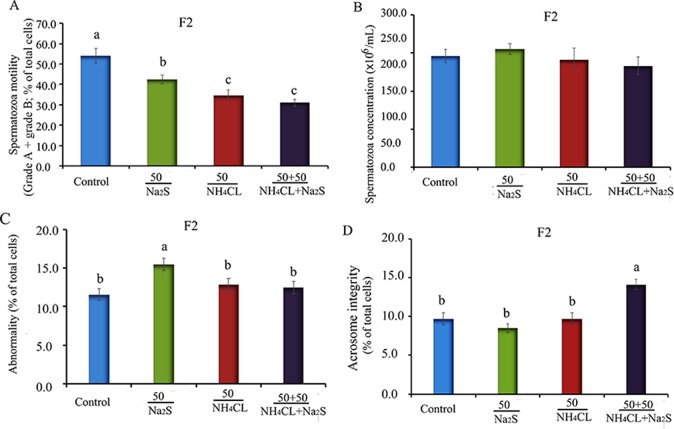
(A) F2 mice sperm motility. Y-axis = percentage of total cells, X-axis = the treatment concentration (mg/kg body weight). (B) F2 mouse sperm concentration. Y-axis = number of cells, X-axis = the treatment concentration (mg/kg body weight). (C) The abnormality of F2 mouse spermatozoa detected by eosin Y staining. (D) The abnormal acrosome integrity of F2 mouse spermatozoa detected by commas blue staining. N > 6. a, b, c indicate a significant difference among different treatments (p < 0.05).